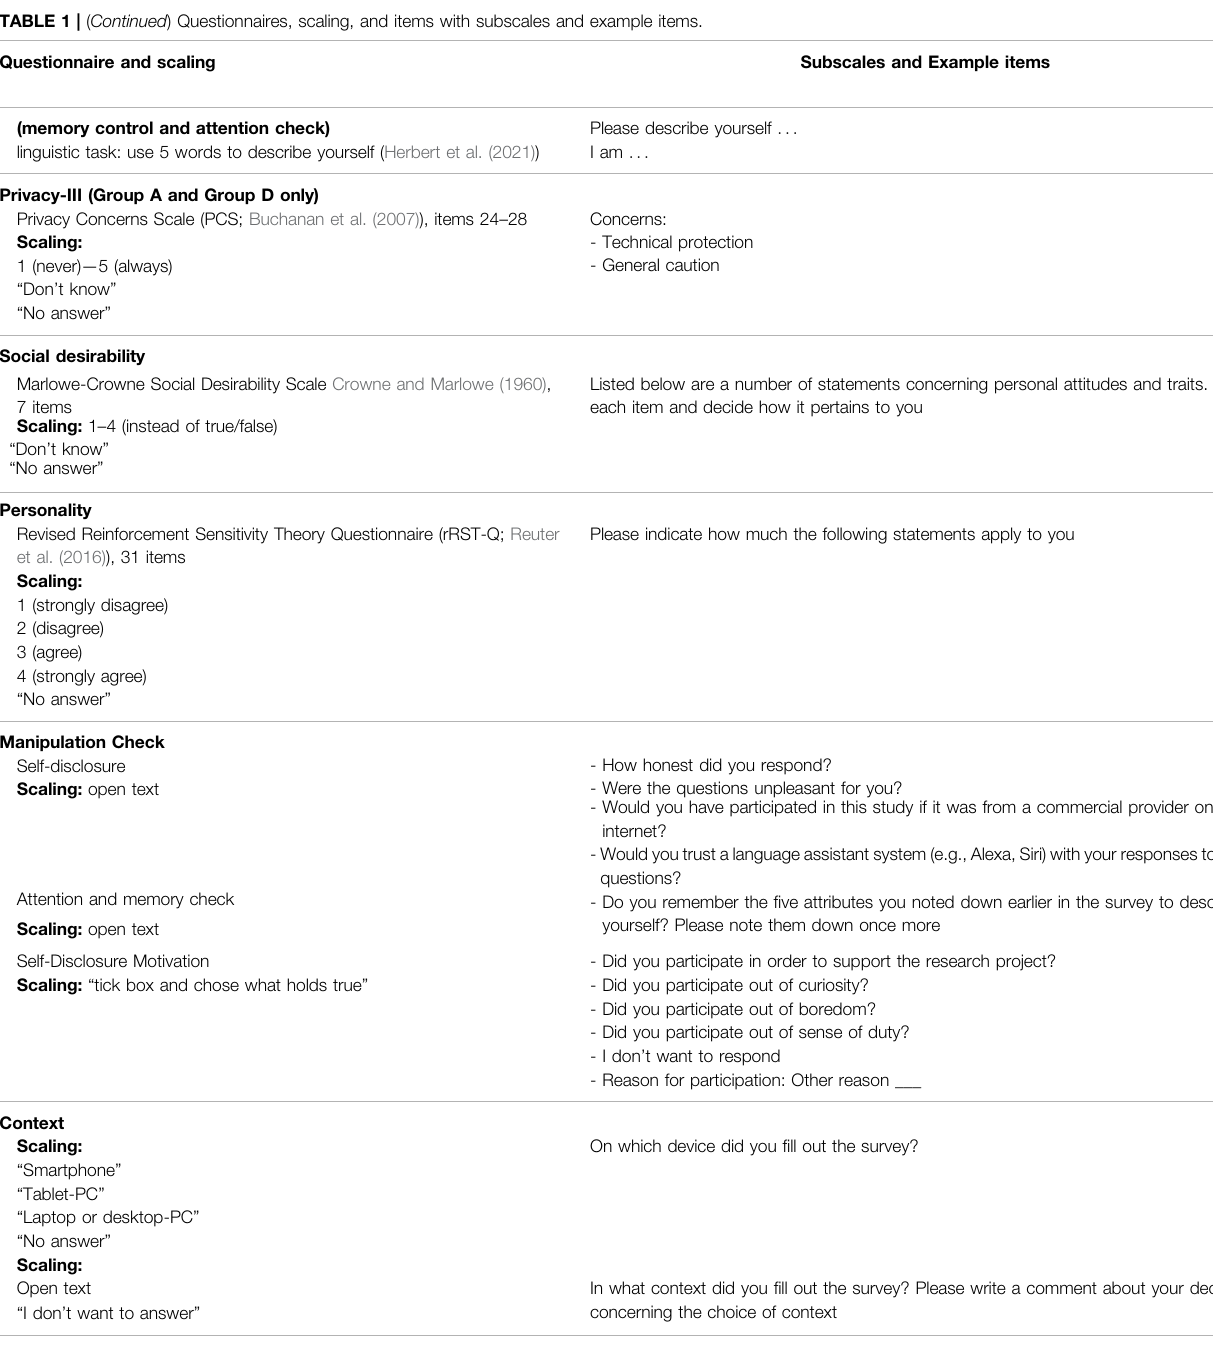
(memory control and attention